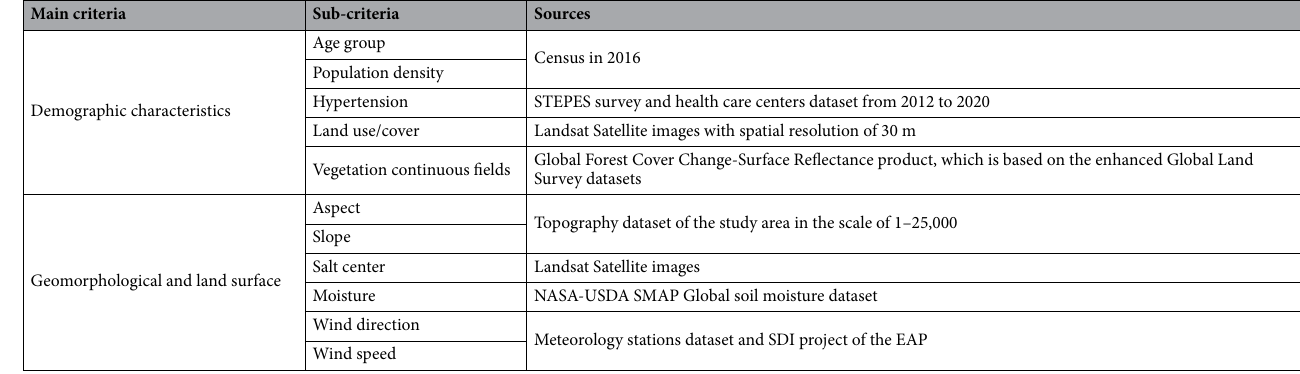
Table 1. Datasets employed in this